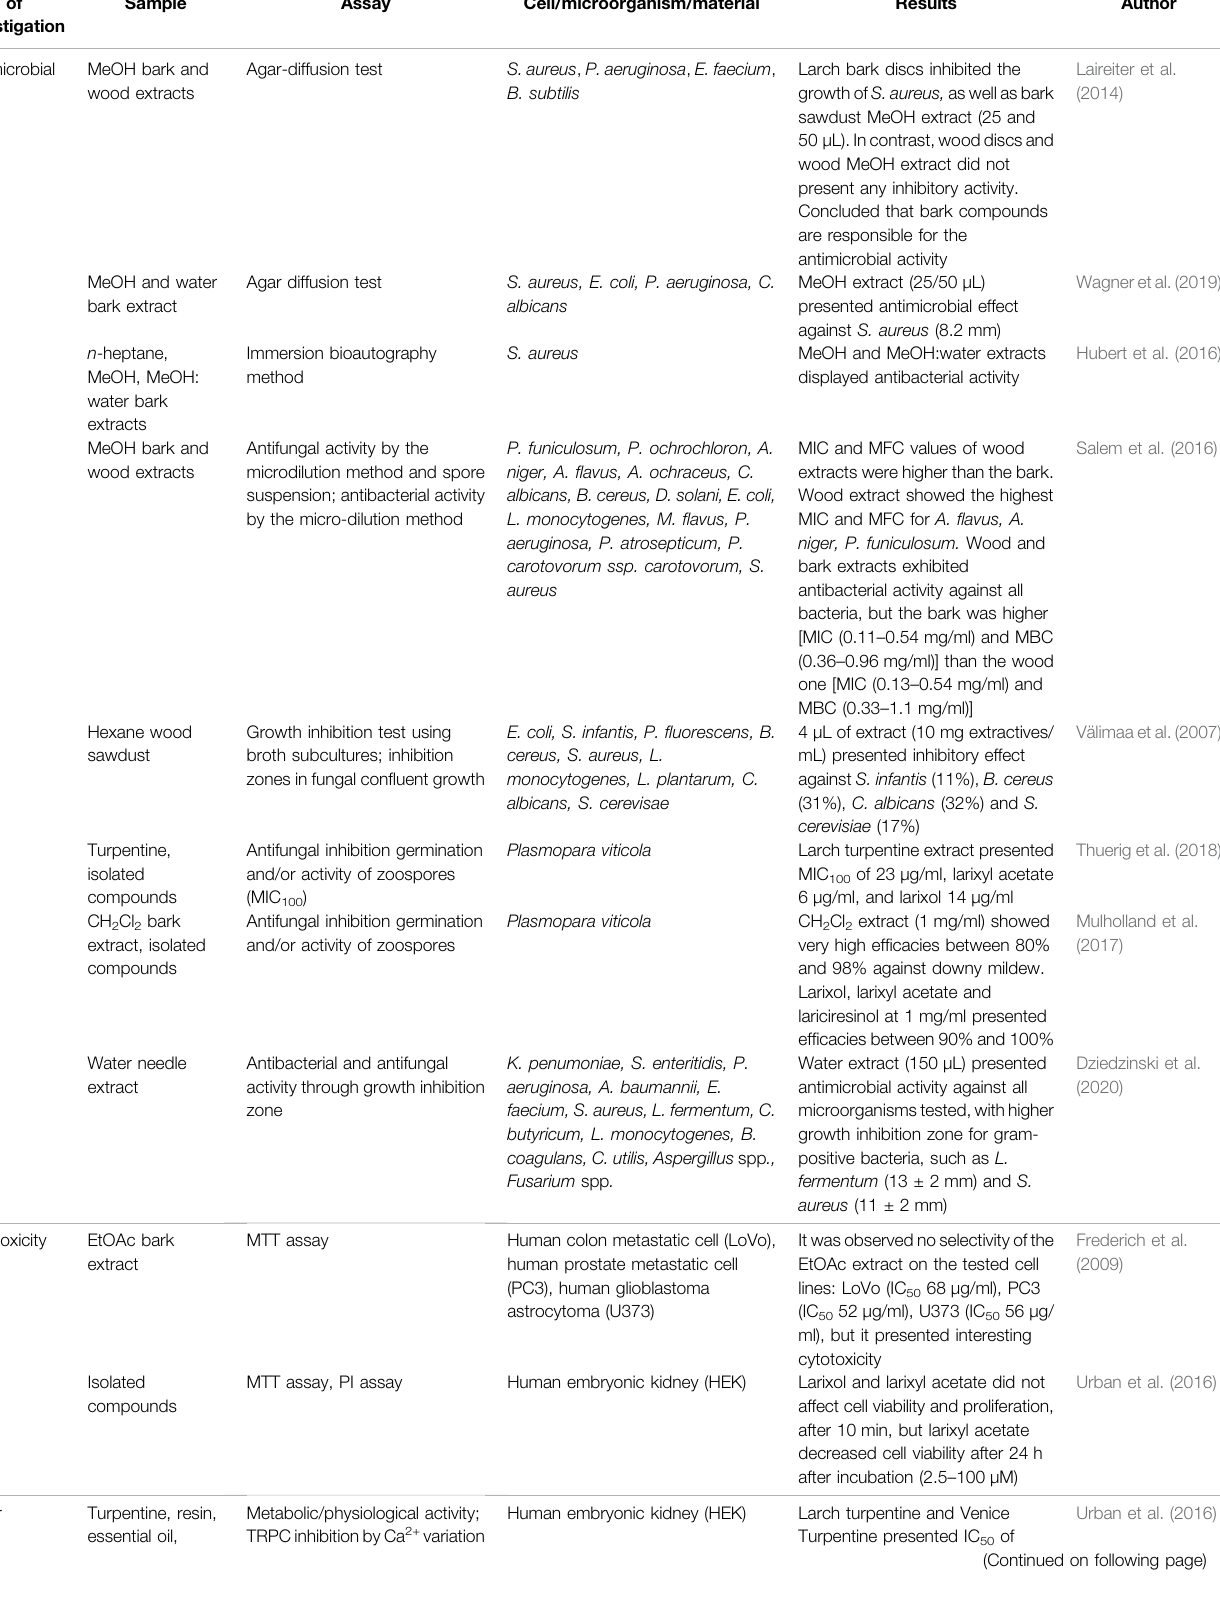
TABLE 3 | Biological in vitro studies with Larix decidua Mill.